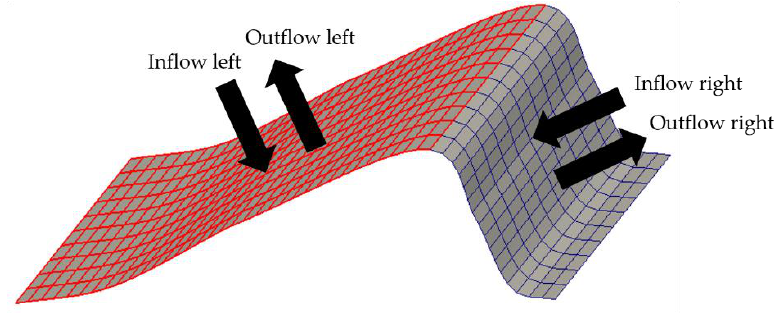
Figure 5. In- and outflowing fluxes at the left and right side of the ripple crest.